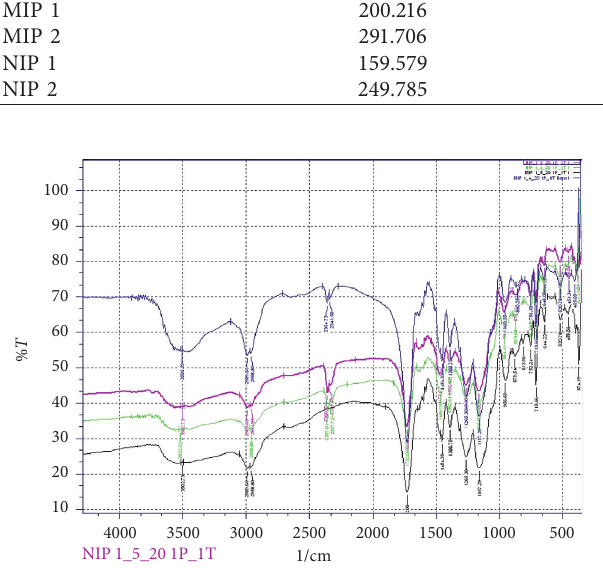
Figure 5: FTIR spectra of the imprinted monolithic columns (blue: MIP 1; black: MIP 2; green: NIP 1; violet: NIP